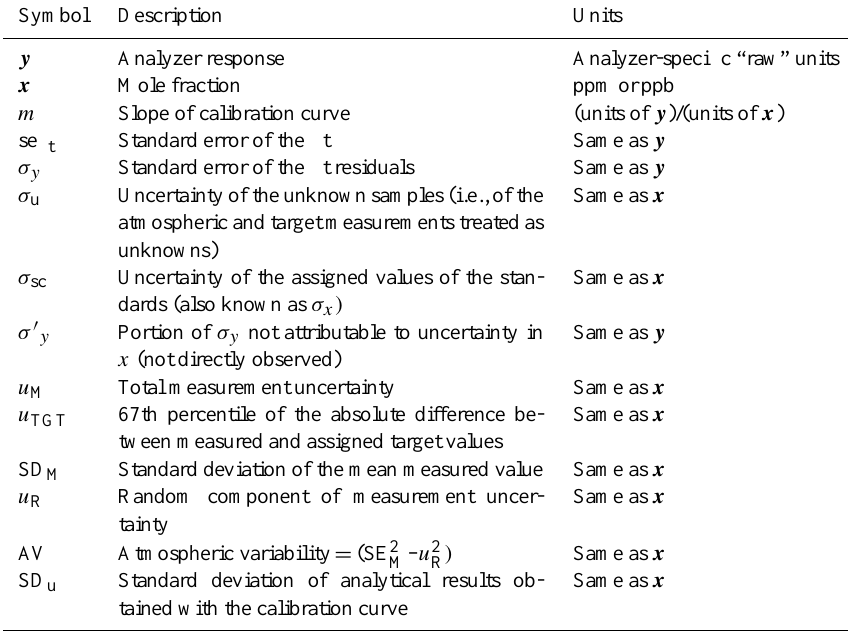
Table D1. Glossary of uncertainty terms. Symbol Description Units y Analyzer response Analyzer-specific “raw” units x Mole fraction ppm orppb m Slope of calibration curve (units of y )/(units of x ) se fit Standard error of the fit Same as y σ y Standard error of the fit residuals Same as y σ u Uncertainty of the unknown samples (i.e., of the Same as x atmospheric and target measurements treated as unknowns) σ sc Uncertainty of the assigned values of the stan- Same as x dards (also known as σ x ) Portion of σ y not attributable to uncertainty in Same as y x (not directly observed) Total measurement uncertainty Same as x 67th percentile of the absolute difference be- Same as x tween measured and assigned target values SD M Standard deviation of the mean measured value Same as x u R Random component of measurement uncer- Same as x tainty ) Same as x AV Atmospheric variability = (SE 2 – u 2 M R SD u Standard deviation of analytical results ob- Same as tained with the calibration curve